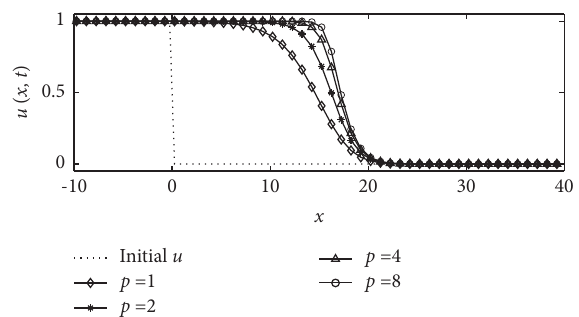
Figure 12: Numerical solutions with different p values.